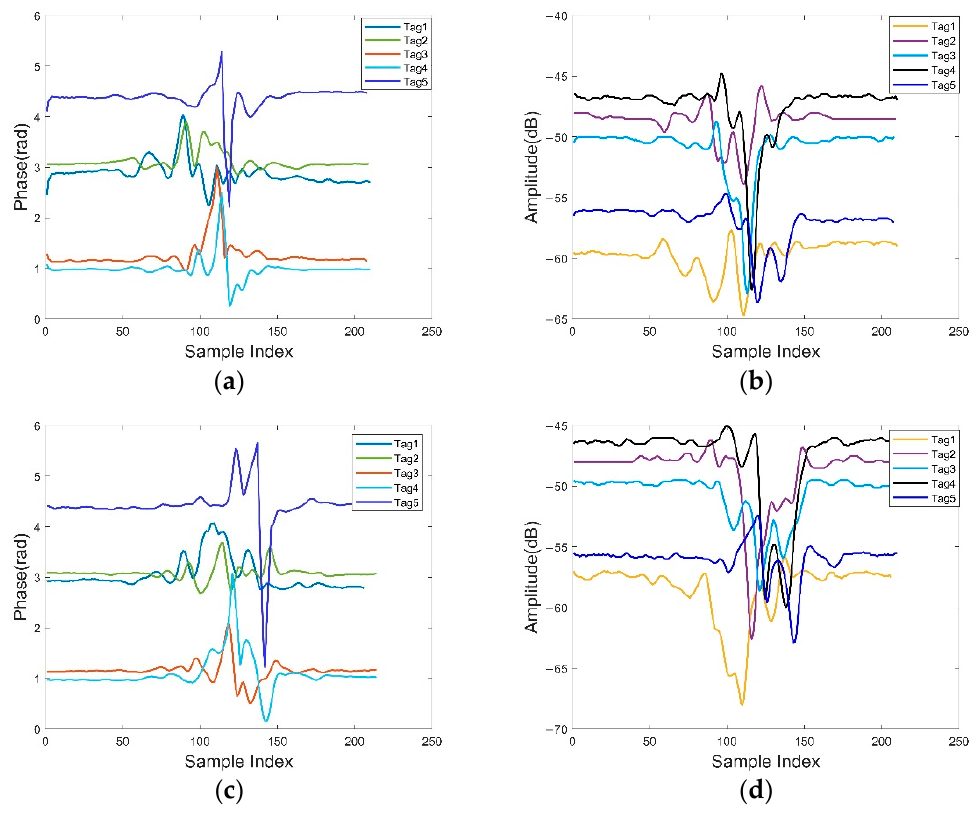
Figure 3. Phase and amplitude readings of two asynchronous volunteers under all five tags: ( a , b ) are the phase and amplitude of volunteer 1; ( c , d ) are the phase and amplitude of volunteer 2. In order to detect multiple users, in the second experiment we had two volunteers with different step lengths and two volunteers with the same step length continuously walk through the corridor detection area. Figure 4 shows two different sets of phase and